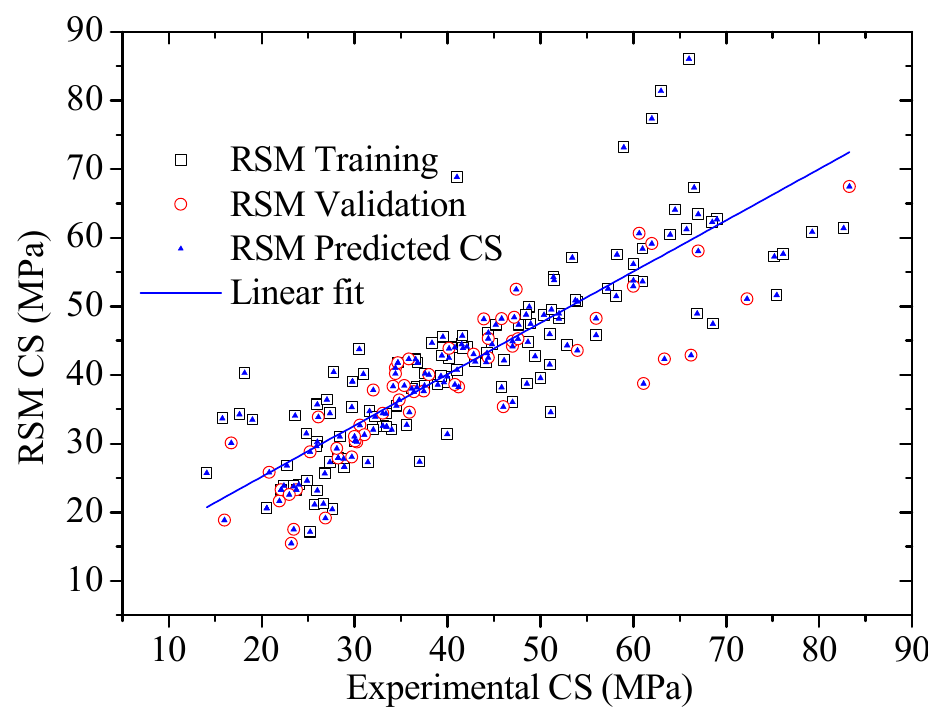
Figure 6. RSM: training, validation, and testing.